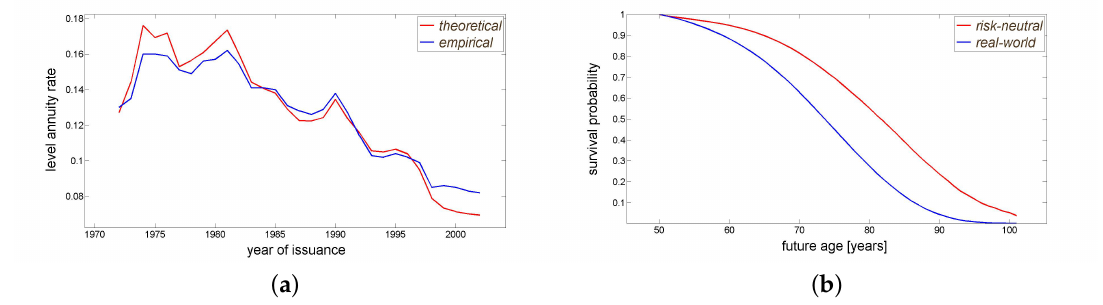
Figure 6. Level Annuities of [37] ( a ) and Survival Probabilities ( b